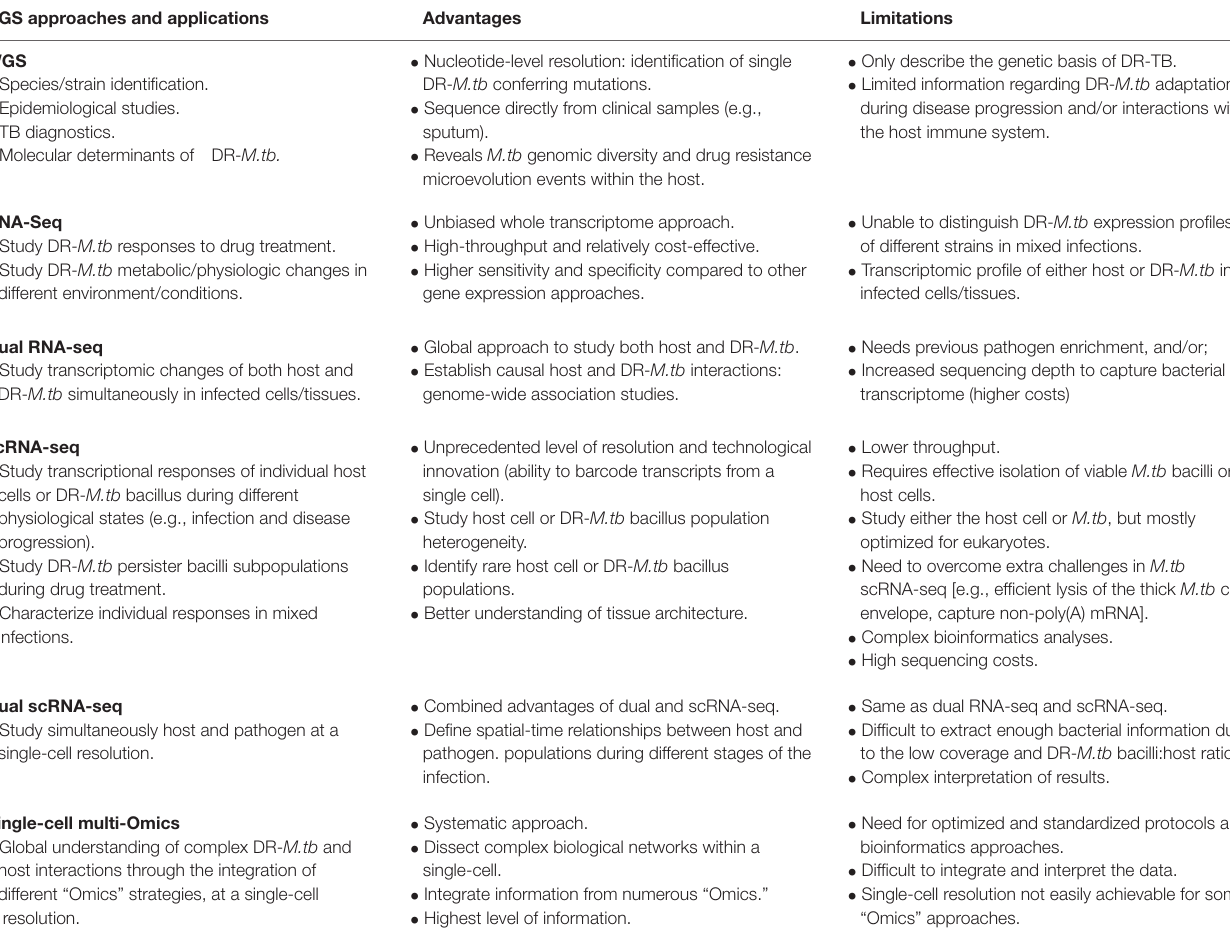
TABLE 2 | Next generation sequencing (NGS) strategies for drug-resistant Mycobacterium